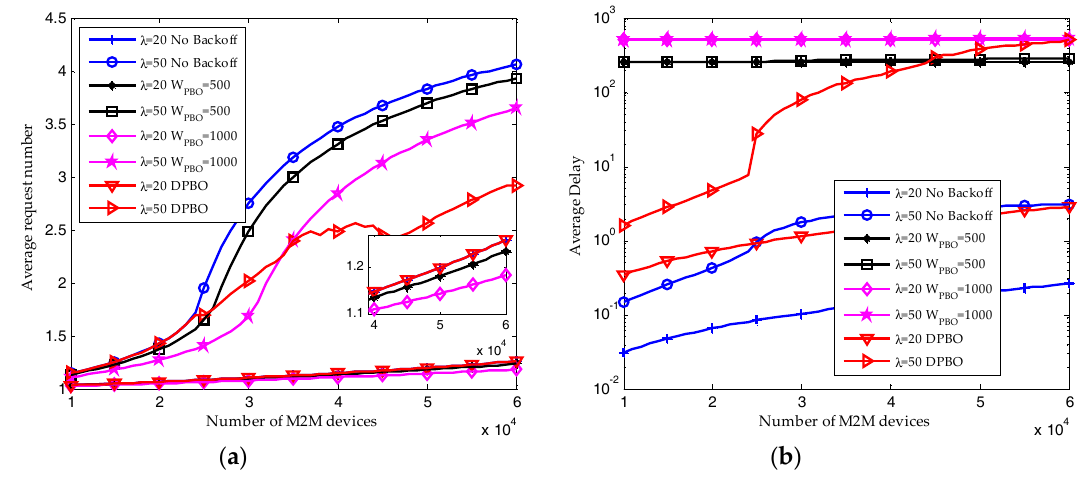
Figure 13. Performance results of HSTMAC protocol with dynamic pre-backoff scheme (Q = 10, W BO = 20): ( a ) Average request number of M2M traffic; ( b ) Average delay of M2M traffic (granularity in cycles).